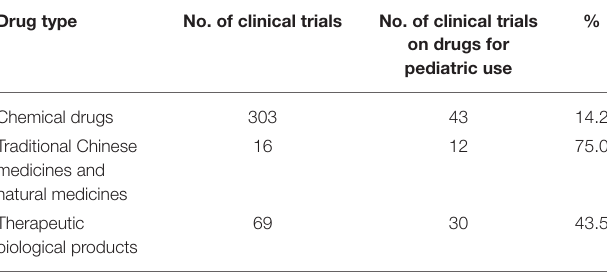
TABLE 8 | Distribution of pediatric trials by drug type. Drug